Question: State the chart type depicted above.
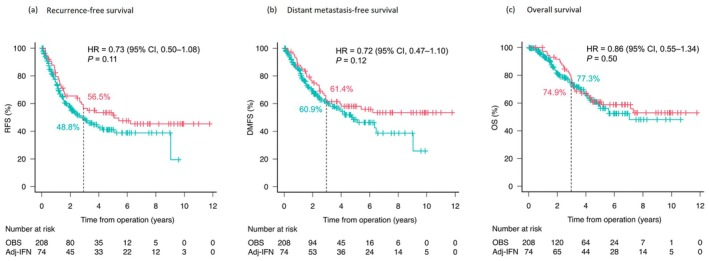
Answer: survival